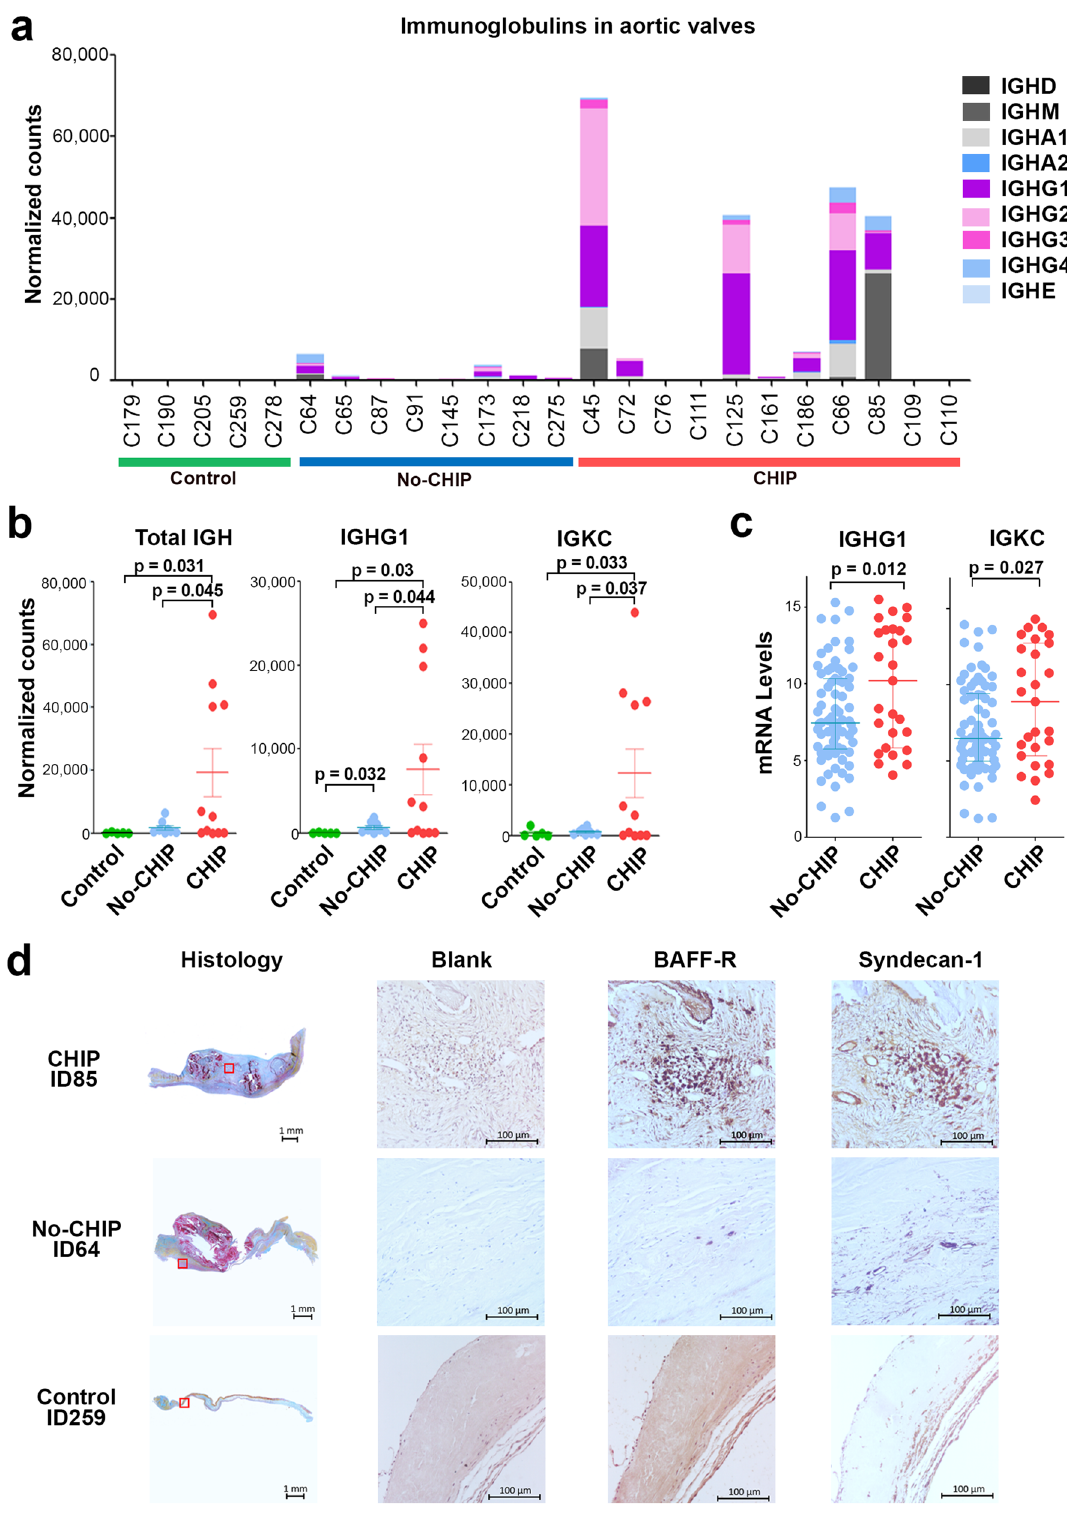
Figure 5. Immunoglobulins analysis and histological images of the aortic valves. ( a ) Content of immunoglobulins-related transcripts in aortic valve samples. ( b ) Quantification by RNA-Seq of immunoglobulins-related transcripts in control, no-CHIP, or CHIP samples. Lines indicate the mean with SEM, p values are referred to T-test comparisons between different groups. ( c ) Quantification by qRT- PCR of representative immunoglobulins transcripts in RNA extracted from No-CHIP and CHIP samples. ( d ) Representative images of aortic valves of controls, No-CHIP, CHIP samples. Histological staining on the right shows the entire cusp after Russell-Movat pentachrome staining identifying elastin fibers (black), collagens (yellow), proteoglycans (blue), muscle (red), and cell nuclei (purple). Red squares indicate the areas corresponding to immunohistochemistry images. BAFF-R or CD138 (Syndecan-1) antibodies were used to stain activated B cells or plasma cells, respectively. Negative control sections (Blank) underwent the same procedure except for the primary antibody, which was